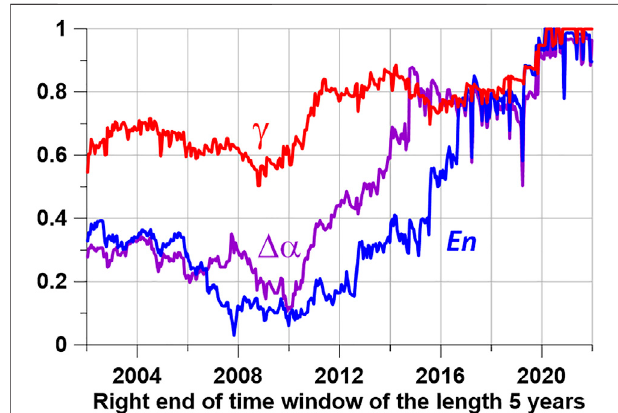
FIGURE 3 | Intensity shares corresponding to the “ excitation ” of seismic events M ≥ 7 by local extrema of average daily values of seismic noise properties:DJ-index γ minima(redline),singularityspectrumsupportwidth Δα minima (purple line), normalized entropy En maxima (blue line).